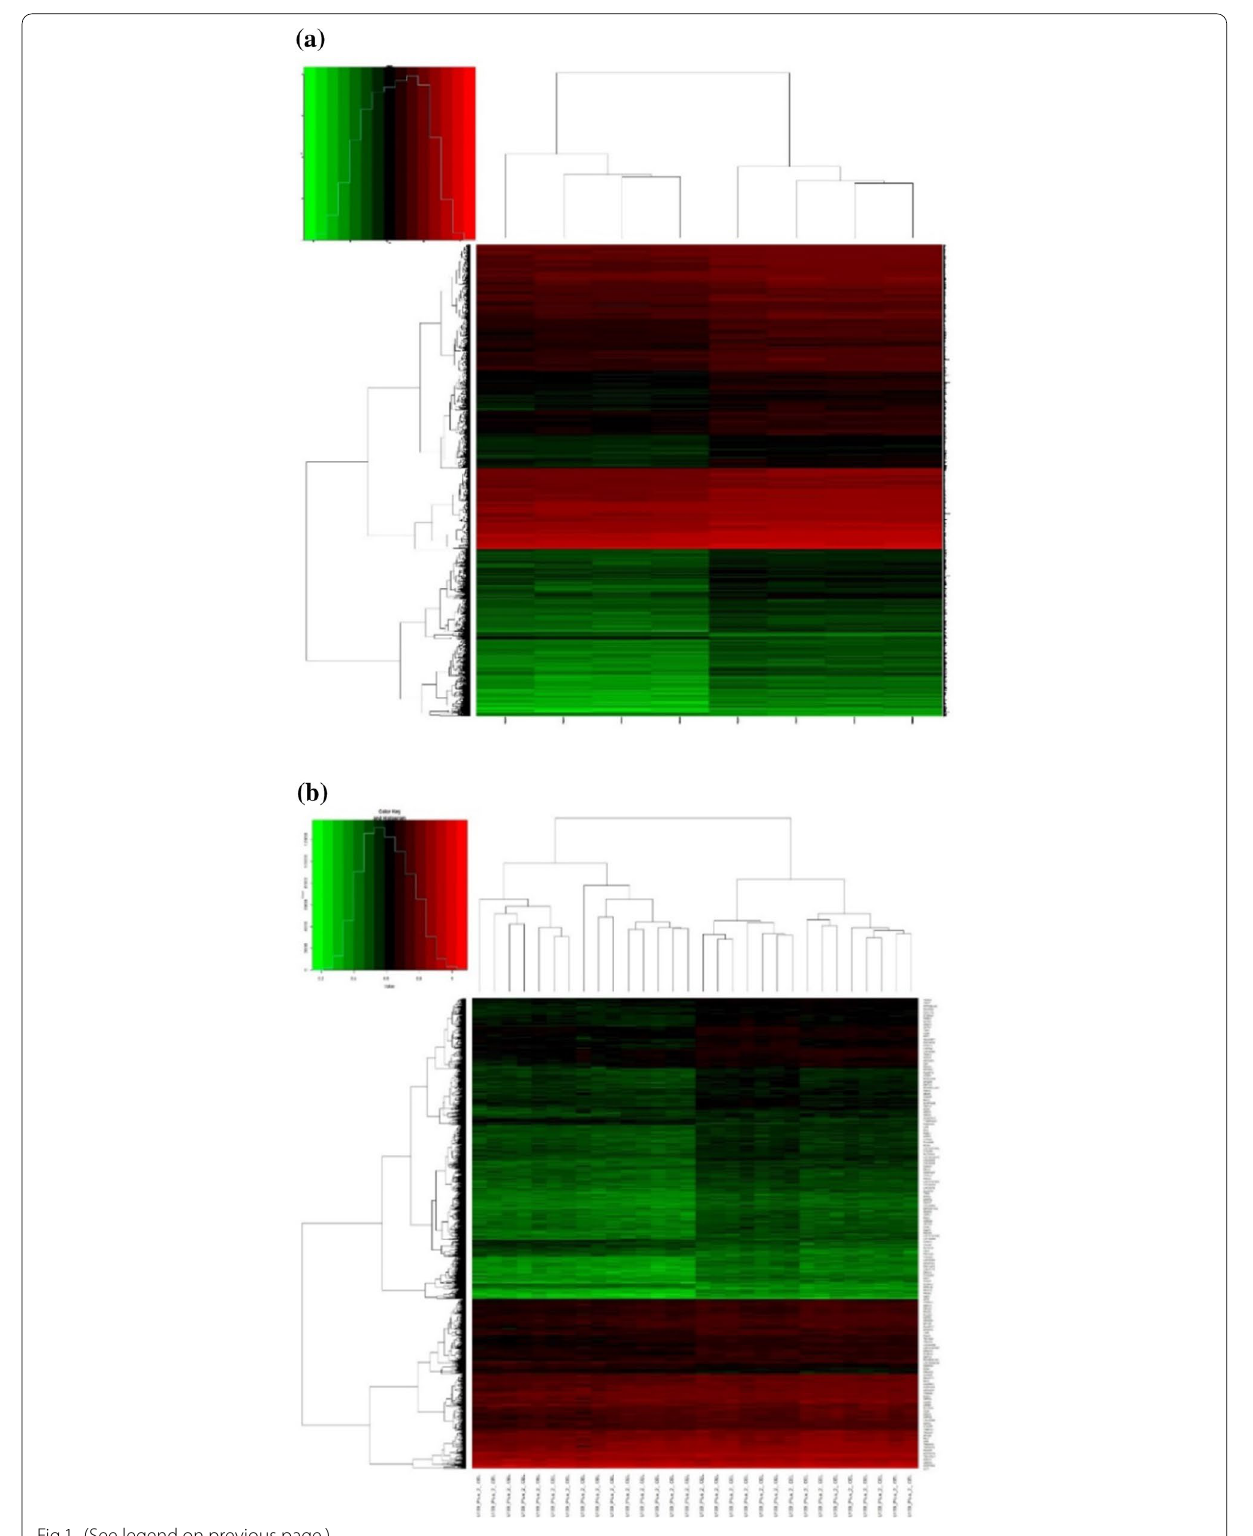
Fig.1 (See legend on previous